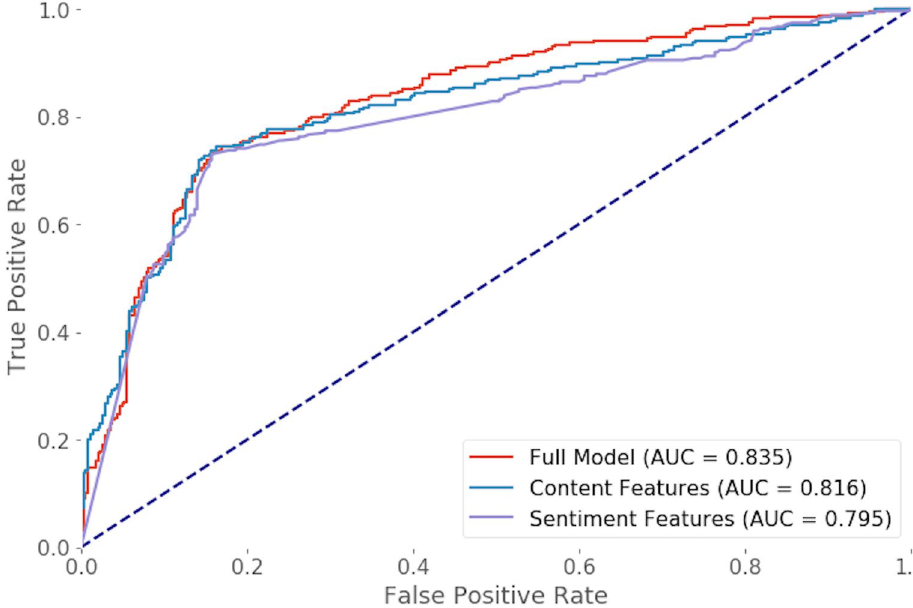
Figure 2. ROC curve of the O.I. prediction model. The legend indicates which features were used for the